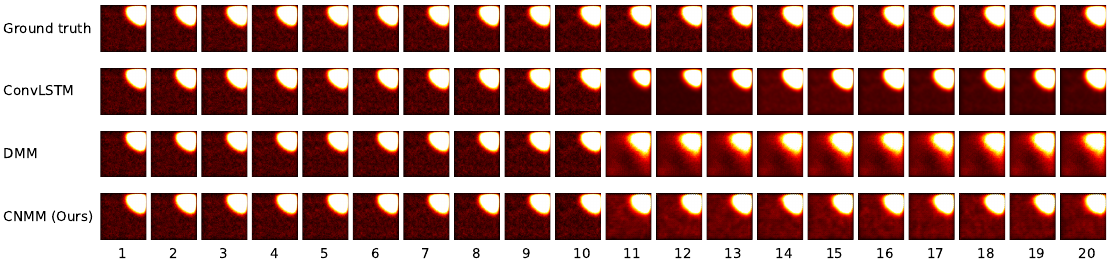
Figure 10. 2D heatmap visualization of the forecast result of the same data used in Figure 8 (2D heat equation data). Prediction starts from the 11th timestep onward. Brighter region means higher temperature.